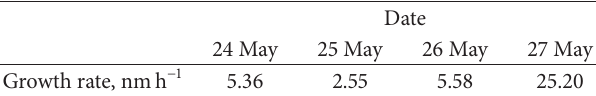
Table 1: The growth rate of new